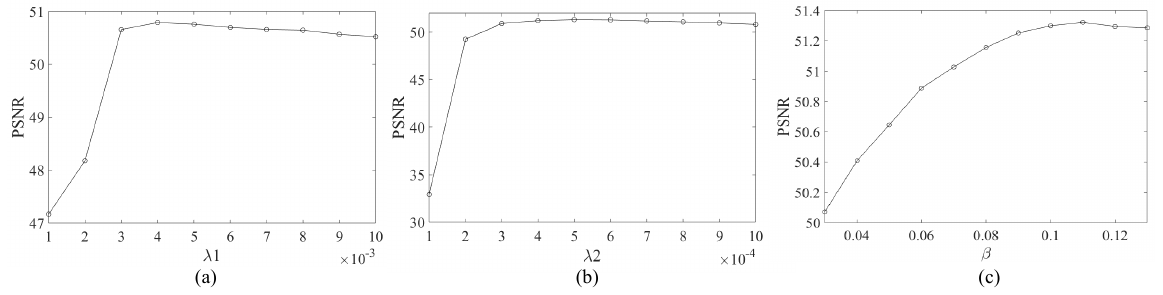
Figure 3. Parameter analysis of Case 3. The PSNR curve as a function of: ( a ) λ 1 ; ( b ) λ 2 ; ( c ) β